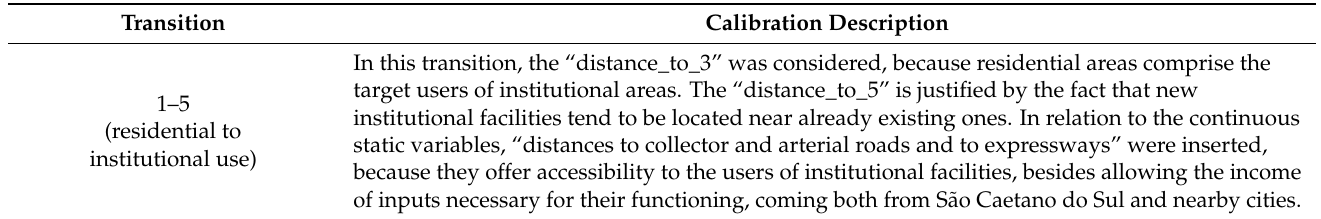
Table 9. Observed transitions from 2018 to 2021 and variables used for